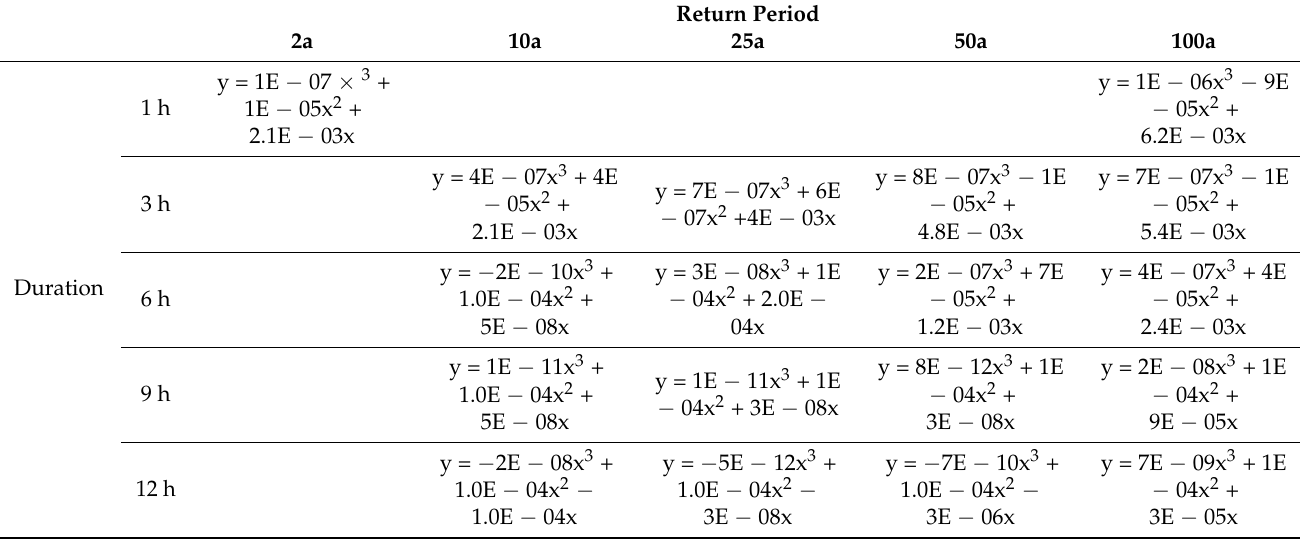
Table 3. Functions relevant for the study area for the determination of the peak runoff coefficient Ψ p (y) on the basis of the degree of sealing (x)